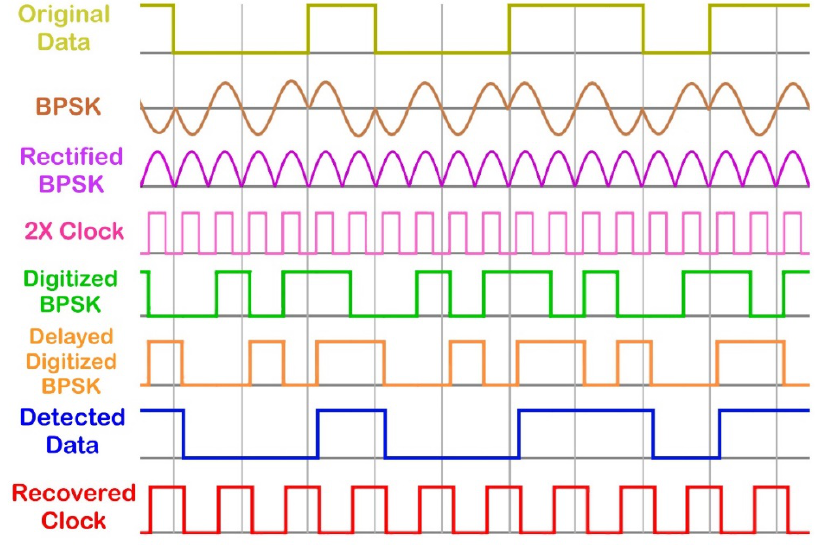
Figure 3. Key waveforms of the proposed demodulator.